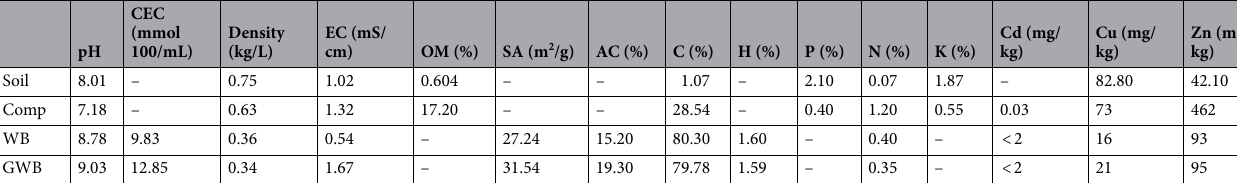
Table 5. Sterilized sandy loam soil containing 5.5% clay (< 2 mm), 42.7% silt (> 2 mm), 51.8% sand (> 63 mm), having